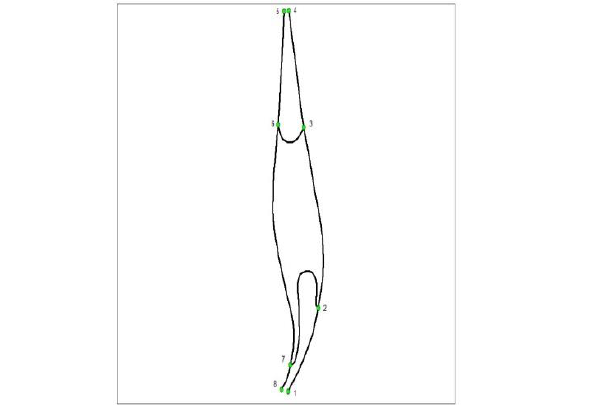
Figure 3- Road and control points extracting from image